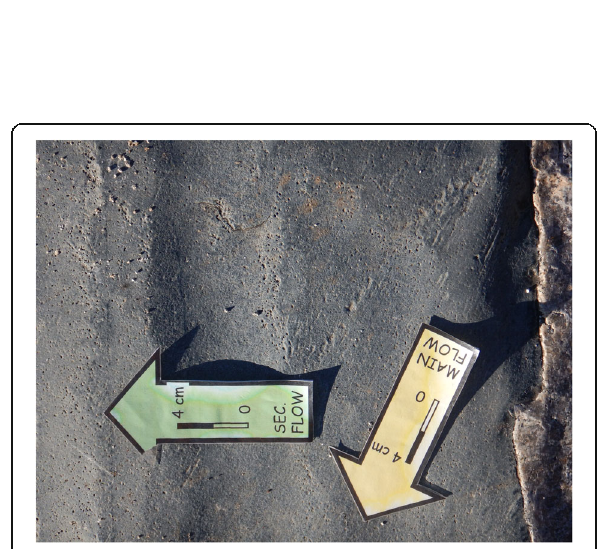
Fig. 10 Microdiorite dyke with a series of crests and troughs. Scratches are superimposed to stoss slopes and steep, concave, lee slopes show pits. North is on the top right of the